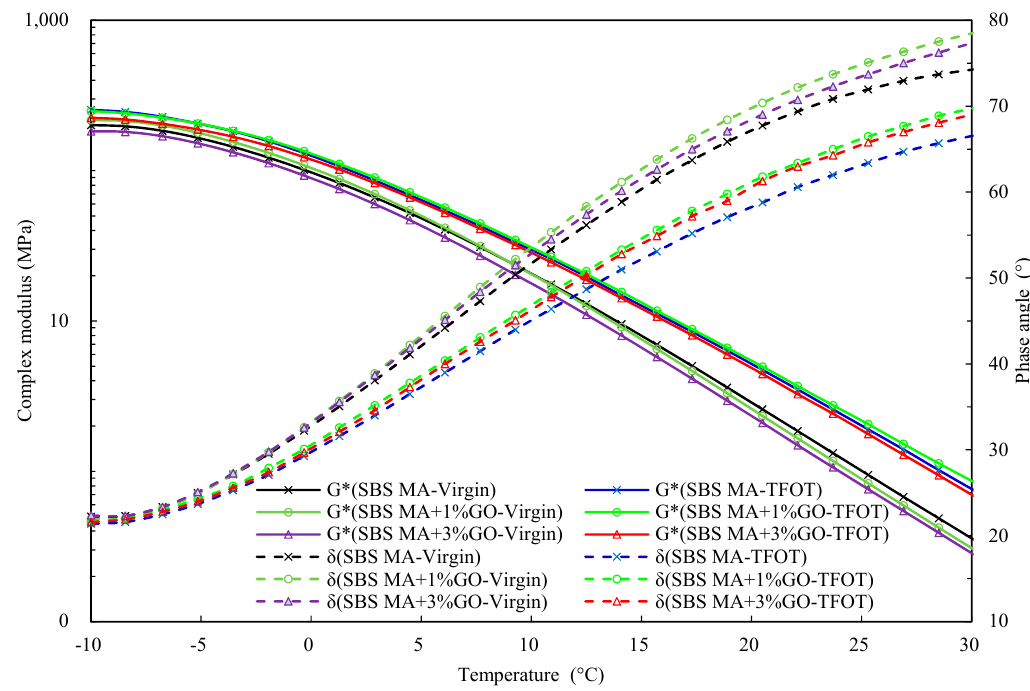
Figure 12. Complex modulus of SBS MA and GO modified SBS MA before and after TFOT.